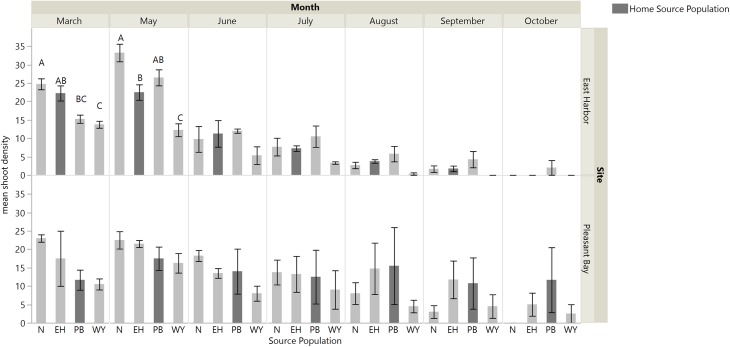
Shoot density for each single source plot at each site (Nahant (N); East Harbor (EH); Pleasant Bay (PB); West Yarmouth (WY)).Significant differences were observed among treatments in March and May at East Harbor at p < 0.05 (mean ± SE); n = 3–4; Tukey’s results denoted by letters (A, B, C). Home source populations shaded dark gray for each site.